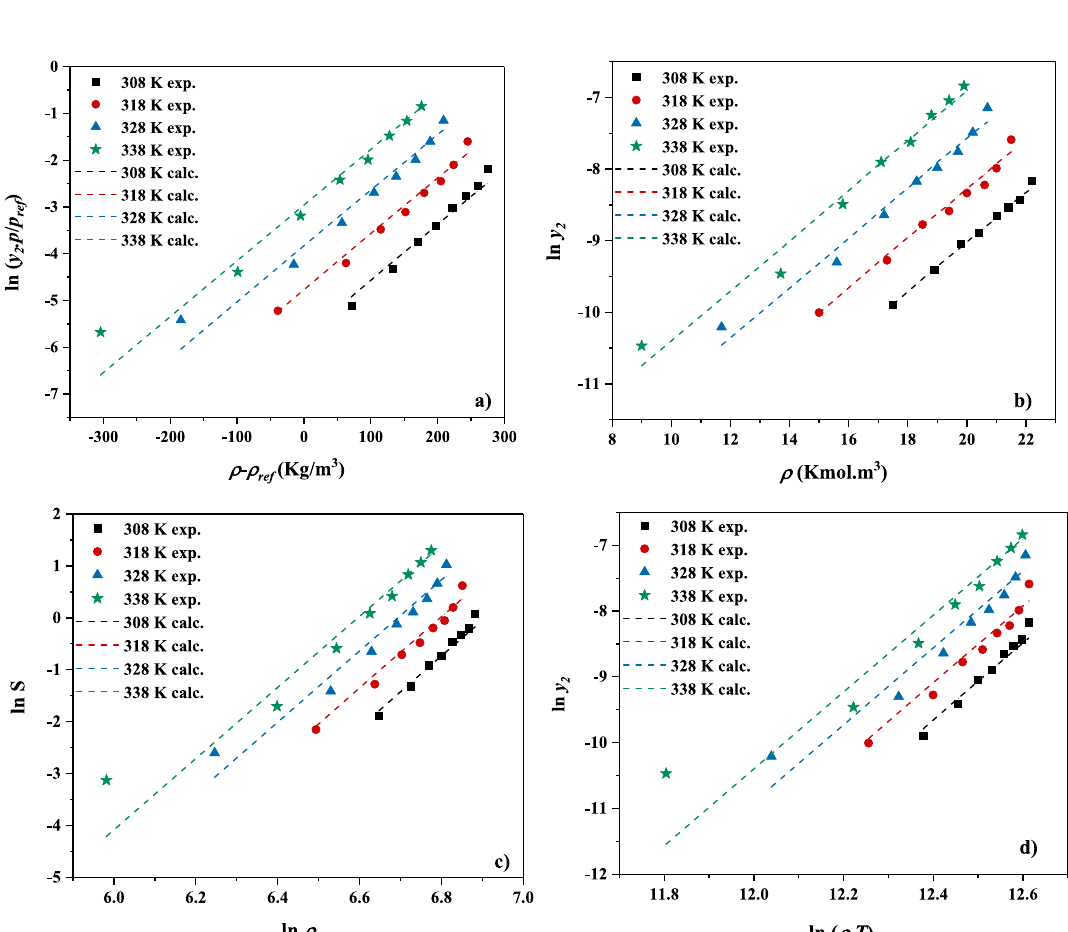
Figure 3. Correlated decitabine solubility using ( a ) Bartle et al. model, ( b ) KJ model, ( c ) Chrastil and ( d ) Garlapati and Madras